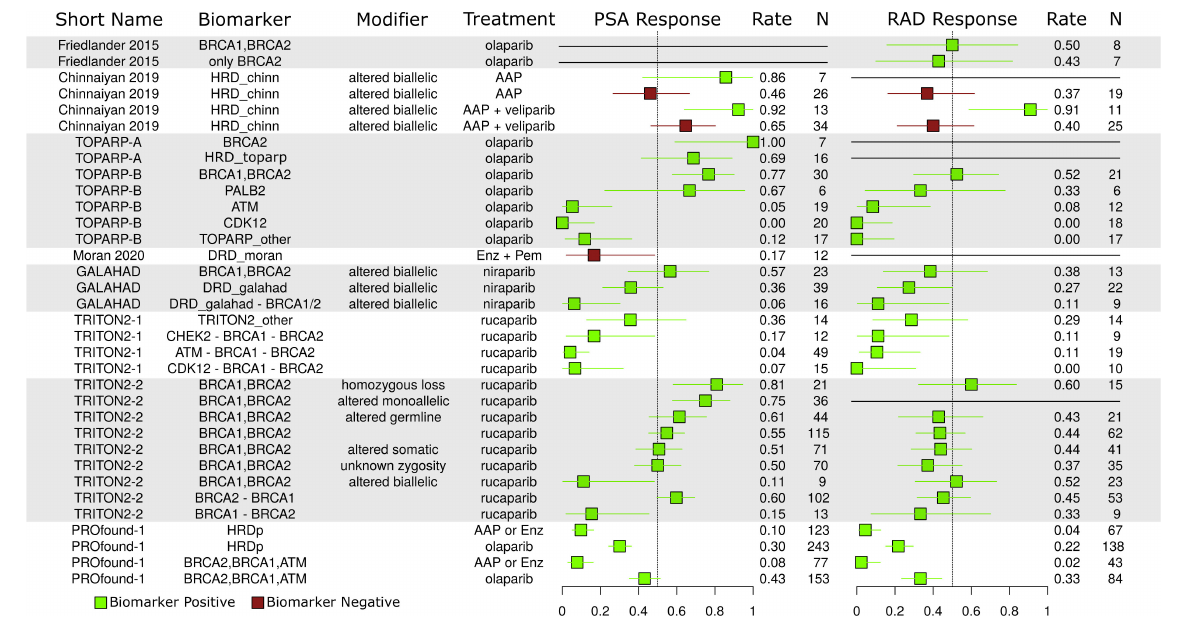
median AE rates across grade and study are stacked and colored by grade. The median rate of serious anemia events was 20% in PARPi populations and ∼ 20% for grade